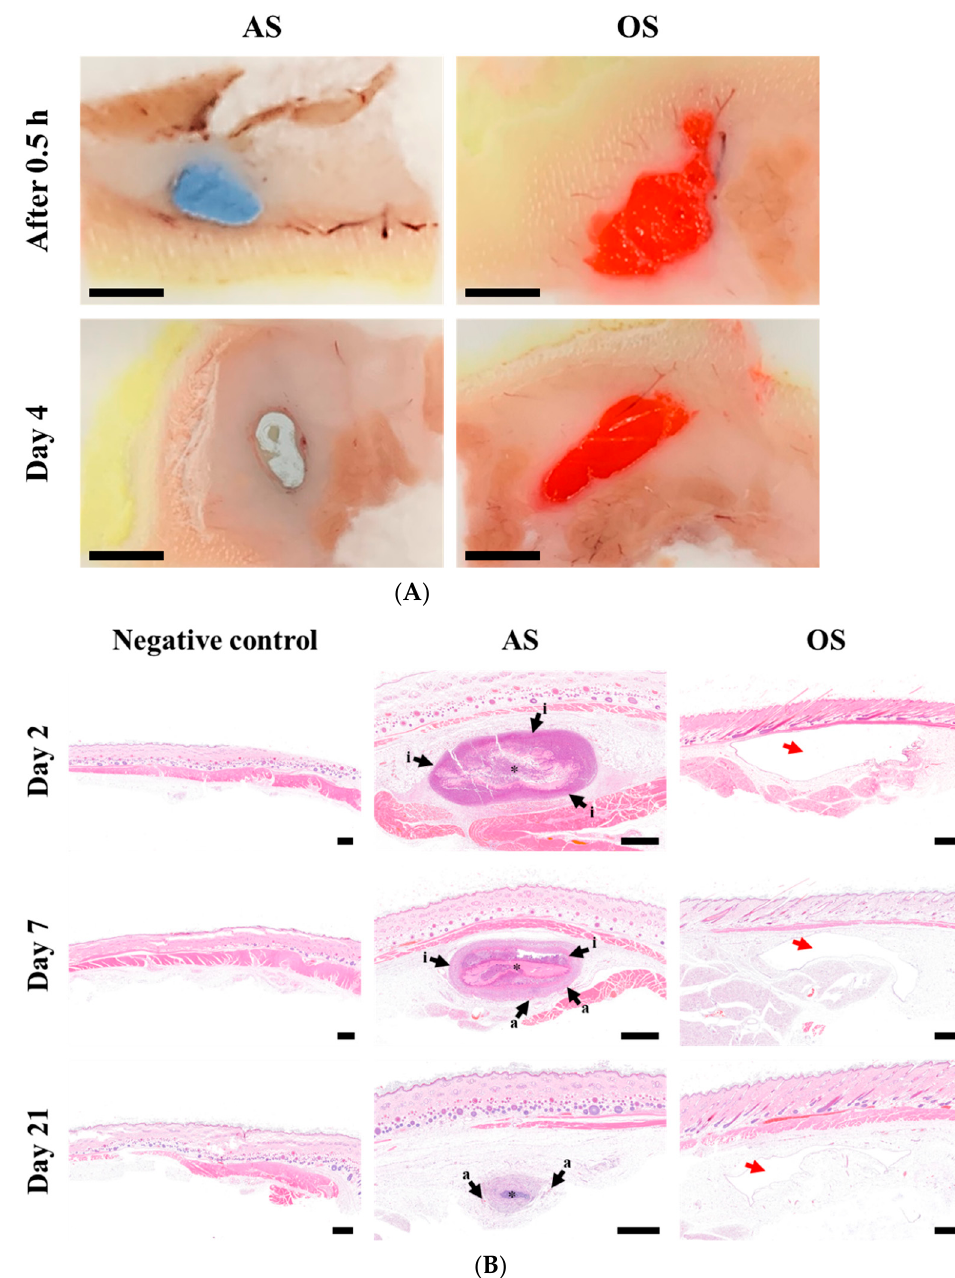
Figure 4. Representative macroscopic and histological images of rat back scruff tissues at 2, 7, and 21 days after SC injection of RTG AS or OS systems (30 mg/kg as RTG). ( A ) Macroscopic images of injected sites at 2, 7, and 21 days after SC injection of RTG AS or OS. ( B ) Histological observation of the HE-stained back scruff tissues followed by SC injection of negative control (normal saline) and RTG OS and AS systems. Notes: ( B ) The depots formed by the injection of RTG AS are indicated by (*) and the injection sites of OS are indicated by red arrows. Black arrows indicate granulocyte or macrophage infiltration (i) and active capillaries or angiogenesis (a). Scale bars in ( A ) and ( B ) represent 5 mm and 1 mm, respectively.